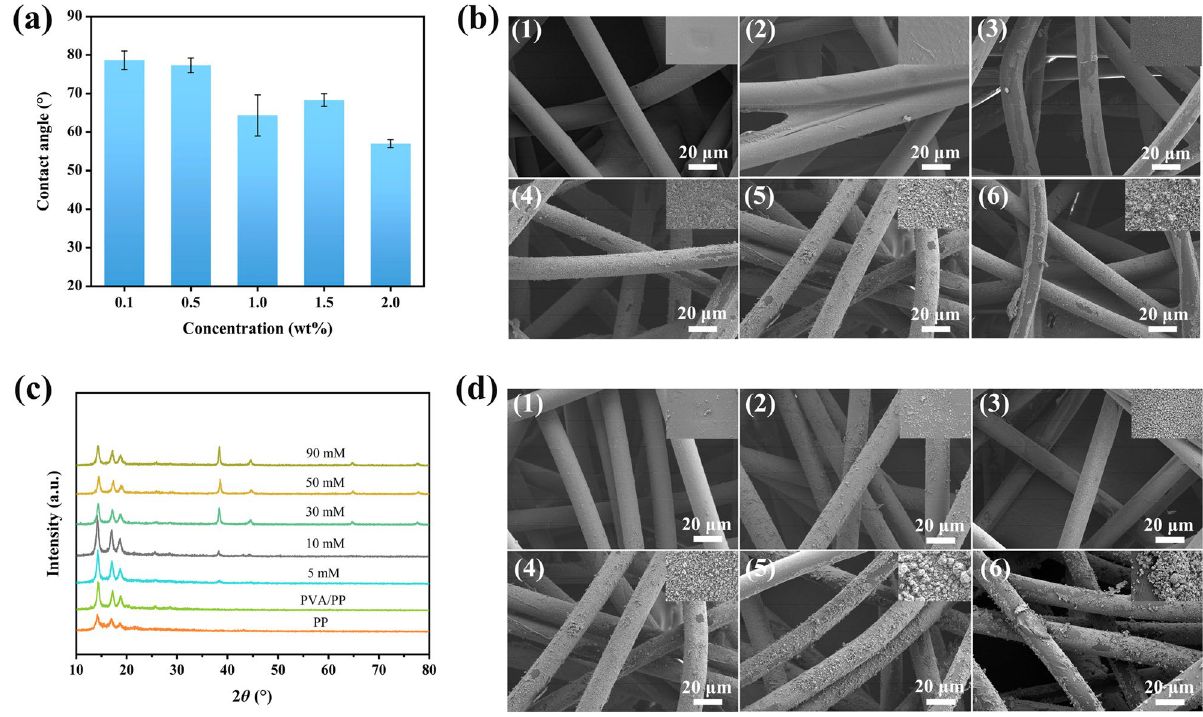
Figure 2. Variation of water contact angle of Ag/PVA/PP fabrics with different PVA concentrations ( a ), SEM images of Ag/PVA/PP fabrics obtained at the silver ammonia concentration of 50 mM and different molar ratios of glucose and silver ammonia [( b ); ( 1 ) PP fiber, ( 2 ) PVA/PP fiber, ( 3 ) molar ration 1:1, ( 4 ) molar ratio 3:1, ( 5 ) molar ratio 5:1, and ( 6 ) molar ratio 9:1], XRD patterns ( c ) and SEM images ( d ) of Ag/PVA/PP fabrics